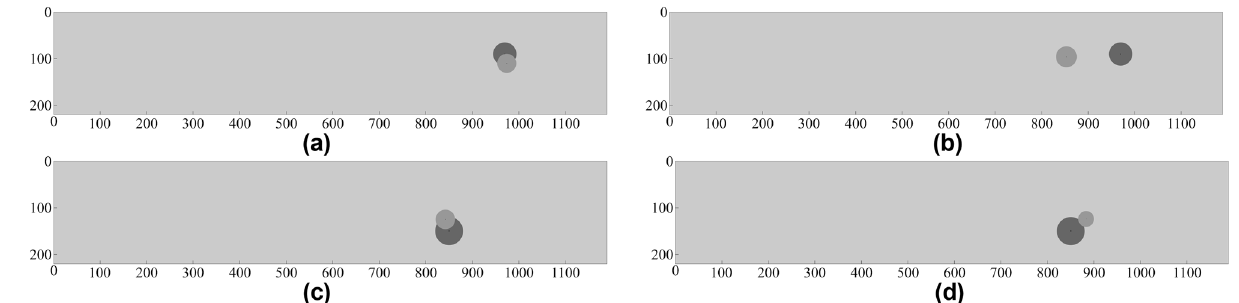
Figure 16. Prediction of geophysical parameters of the object, obtained using the proposed surrogate model and the benchmark model, CNN (using measured data). The target and surrogate-predicted object marked using the dark- and light-grey shade, respectively: Scenario I: D = 90 mm, P = 970 mm, R = 25 mm, ( a ) proposed model, ( b ) CNN; Scenario II: D = 150 mm, P = 850 mm, R = 30 mm, ( c ) proposed model, ( d )